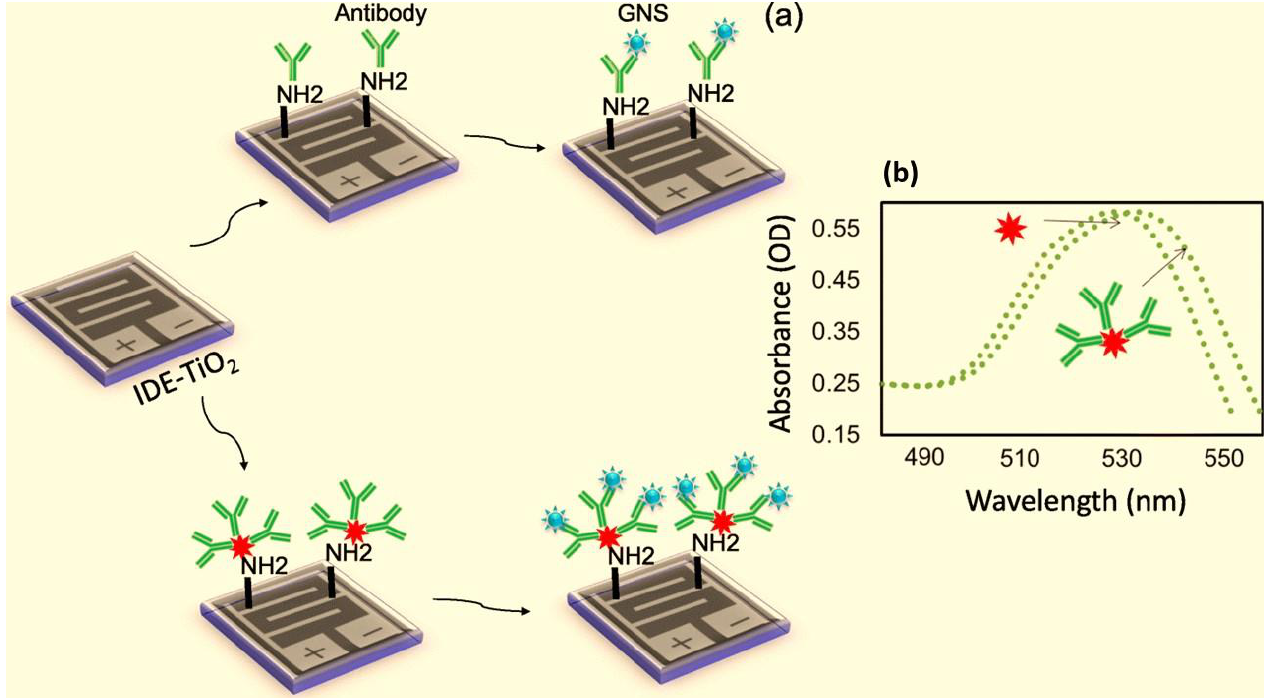
Figure 5. ( a) Schematic representation for the detection of SCC-Ag. IDE-TiO2 surface was modified into amine by APTES followed by the immobilization of antibody or GNS antibody. The amine group from APTES reacted with the carboxyl group on the antibody. SCC-Ag was detected by the interaction at the antigenic region and compared. ( b ) UV-Vis spectroscopy measurements with GNS. Scanning was in the region between 480 and 560 nm, and the peak maxima were ~530 nm. The arrows indicate GNS with and without antibody. Reproduced from [208] .